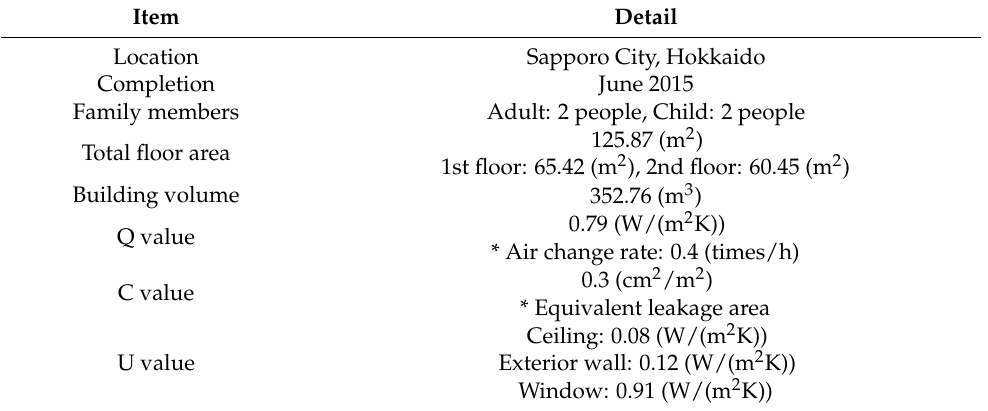
Table 3. Outline of a house.